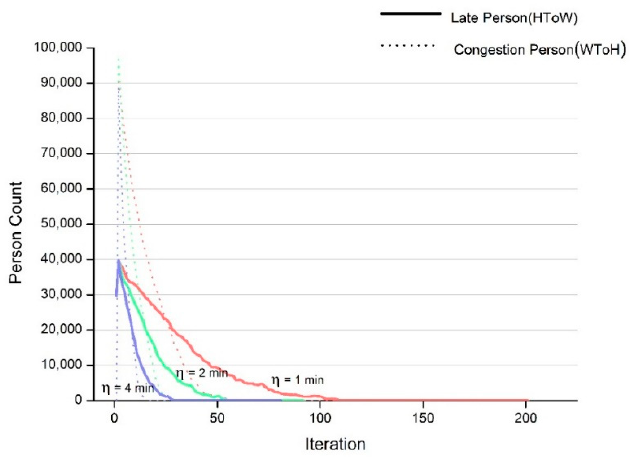
Figure 5. The numbers of person agents who are late or encounter congestion in each iteration. HToW: home to work; WToH: work to home.